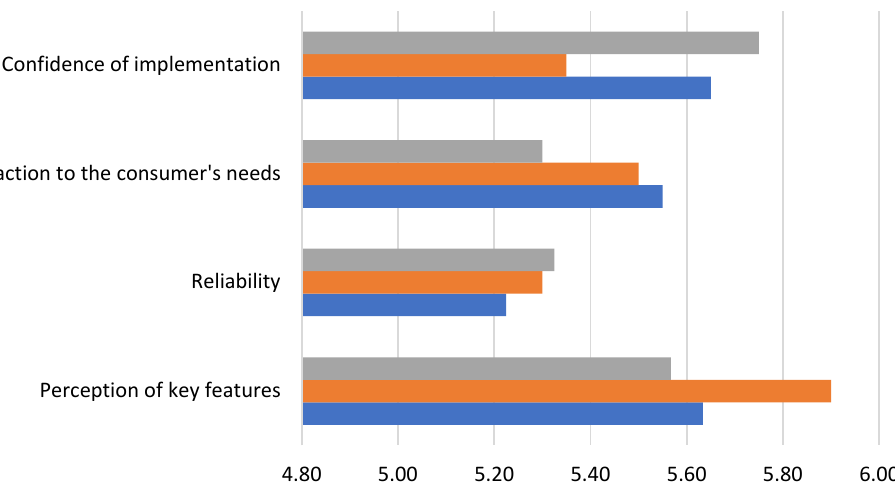
Figure 5. Percentage in relation to the Likert’s scale for the SERVPERF method.